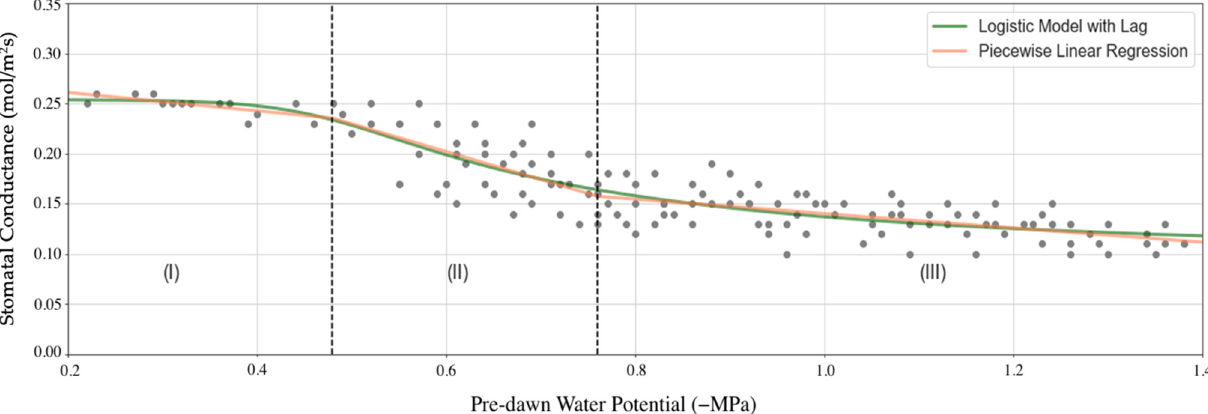
Figure 6. Application of piecewise linear regression and the growth modeling approach on the set of data presented in Figures 4 and 5. The order of appearance of phases is the same as in Figure 5.